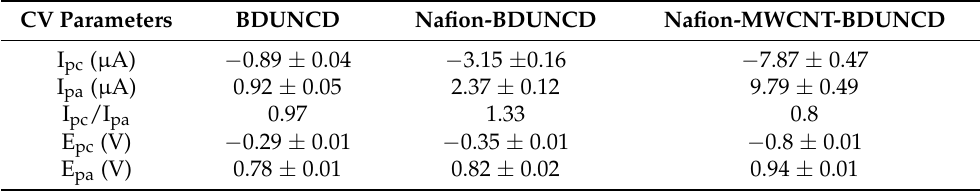
Figure 2. The SEM images of nafion- and nafion–multi-walled carbon nanotube (MWCNT)-coated BDUNCD microelectrodes: ( a ) unmodified BDUNCD microelectrode; ( b ) MWCNT-modified BDUNCD deposition at − 6 V for 10 min; ( c ) nafion–MWCNT-modified BDUNCD microelectrode at +1.5 V for 2 min; ( d ) nafion–MWCNT-modified BDUNCD electrode at a high magnification image of the region shown in the blue square in (c); ( e , f ) the two yellow squares shown in (d). The scale bars for ( a – f ) are 50, 50, 50, 5, 0.5, and 0.5 µ m, respectively. Table 1. Comparison of 100 µ M DA peak oxidation and reduction currents and potentials of the cyclic voltammograms from the three types of BDUCND microelectrodes (unmodified, nafion-modified, and nafion–MWCNT-modified BDUCND) ( n =